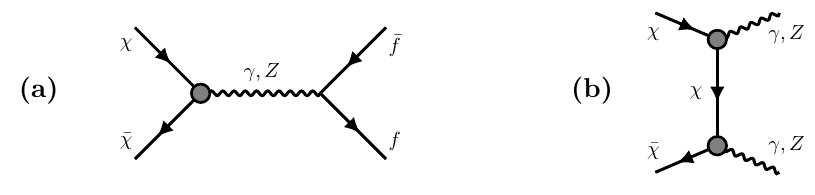
Figure 13 . Loop-level contributions to dark matter annihilation into (a) SM fermions f (depending on the mediating boson), and (b) annihilation directly to pairs of